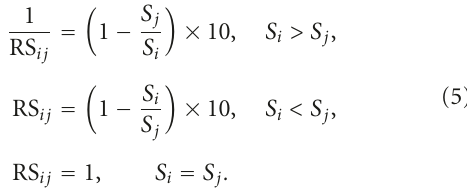
Figure 4: Decision making